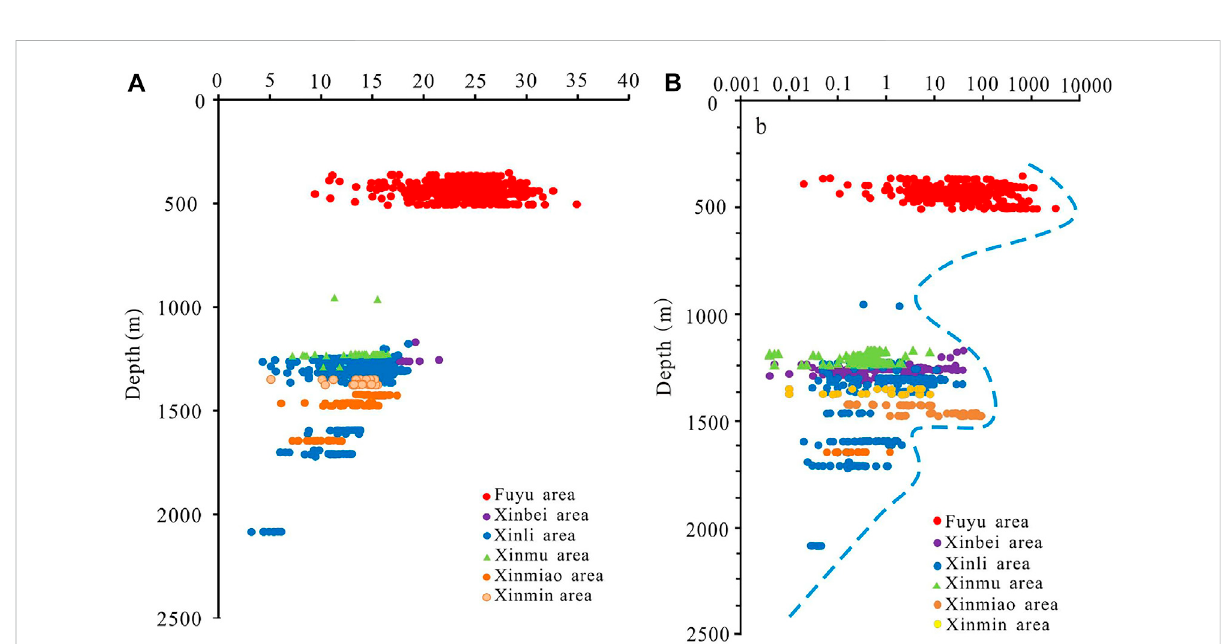
FIGURE 5 Distribution of reservoir properties of Quan 3 Members in different burial depth. Notes: (A) Varition of porosity with depth; (B) Varition of permeability with